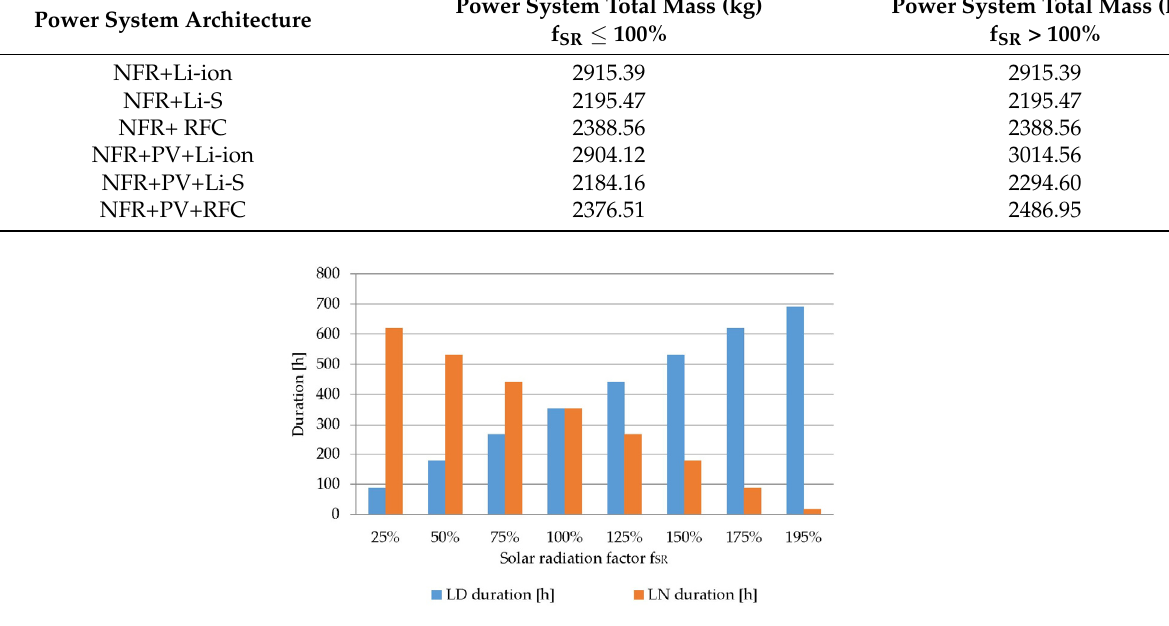
Figure 2. Variations of the lunar day and night durations for different f SR values.